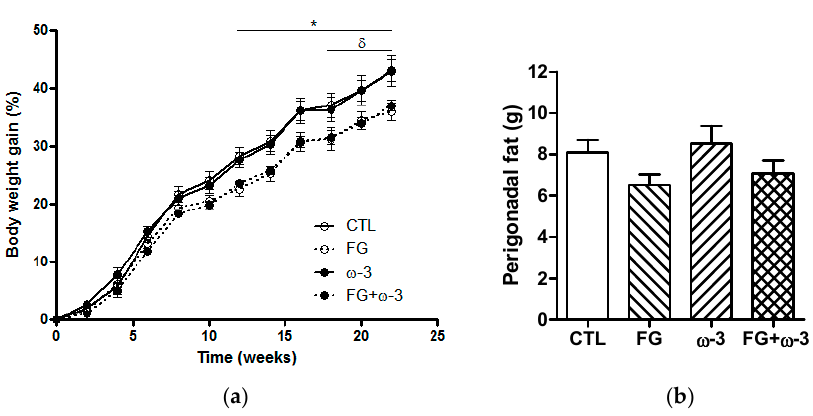
Figure 1. Body weight gain ( a ) and perigonadal fat ( b ) of the different groups (CTL, FG, ω -3 and FG + ω -3) of Sprague–Dawley rats fed a standard diet for 23 weeks. The data represent means with their standard errors. Comparisons were performed using two-way ANOVA for repeated measures ( a ), or one-way ANOVA followed by Tukey's post-hoc test ( b ). * p < 0.05 FG vs. CTL group; δ p < 0.05 FG + ω -3 vs. CTL group.